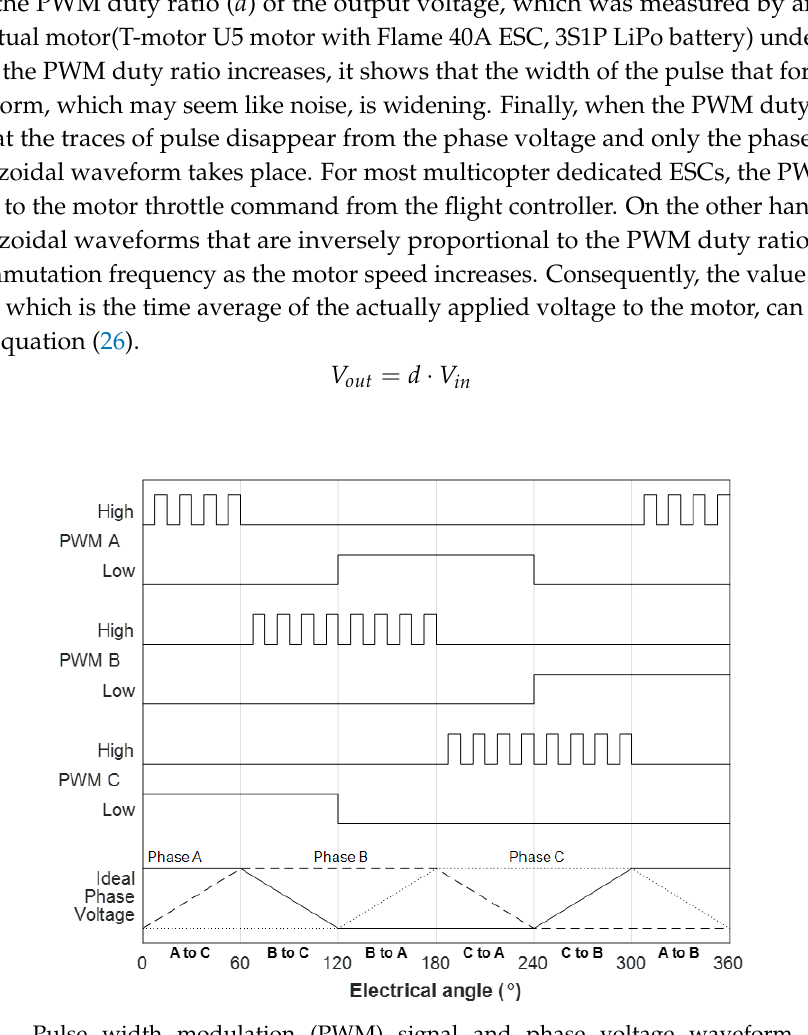
Figure 7. Pulse width modulation (PWM) signal and phase voltage waveform for ideal trapezoidal